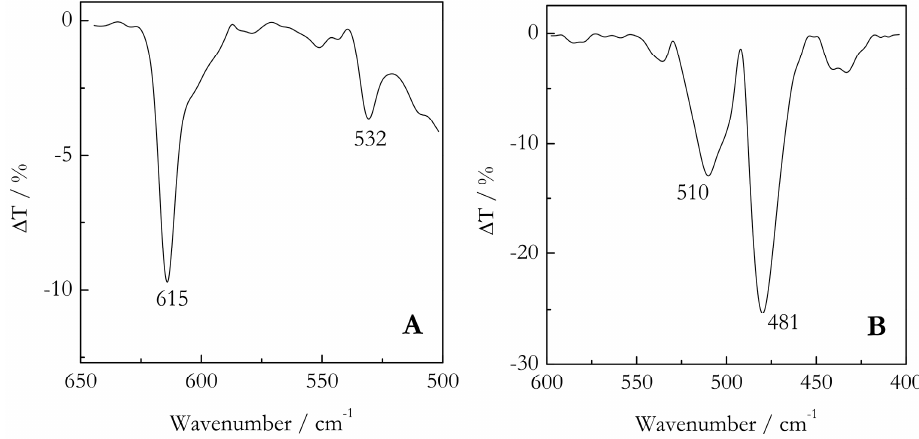
Figure 1. FTIR spectra of the bulk PVDF/TG ( A ) and PVDF/BL ( B ) gels. The vertical axis represents the difference in the transmittance between the gel and solvent.